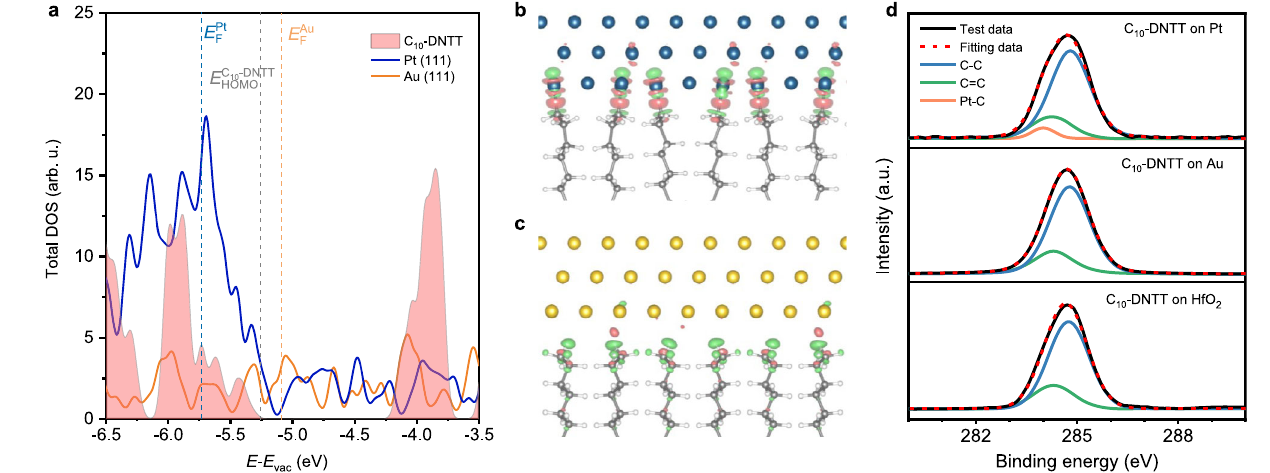
Fig. 3 | Mechanism ofC 10 -DNTT and metal contact. a Total DOS for 1L C 10 -DNTT (pink fi lledregion),Pt(111)(bluesolidline),andAu(111)(yellowsolidline).E F Pt , E F Au , E HOMO C10-DNTT mark the Fermi energy and the energy of valence band maximum for Pt (111), Au (111), and 1L C 10 -DNTT, respectively. b , c Differential charge density